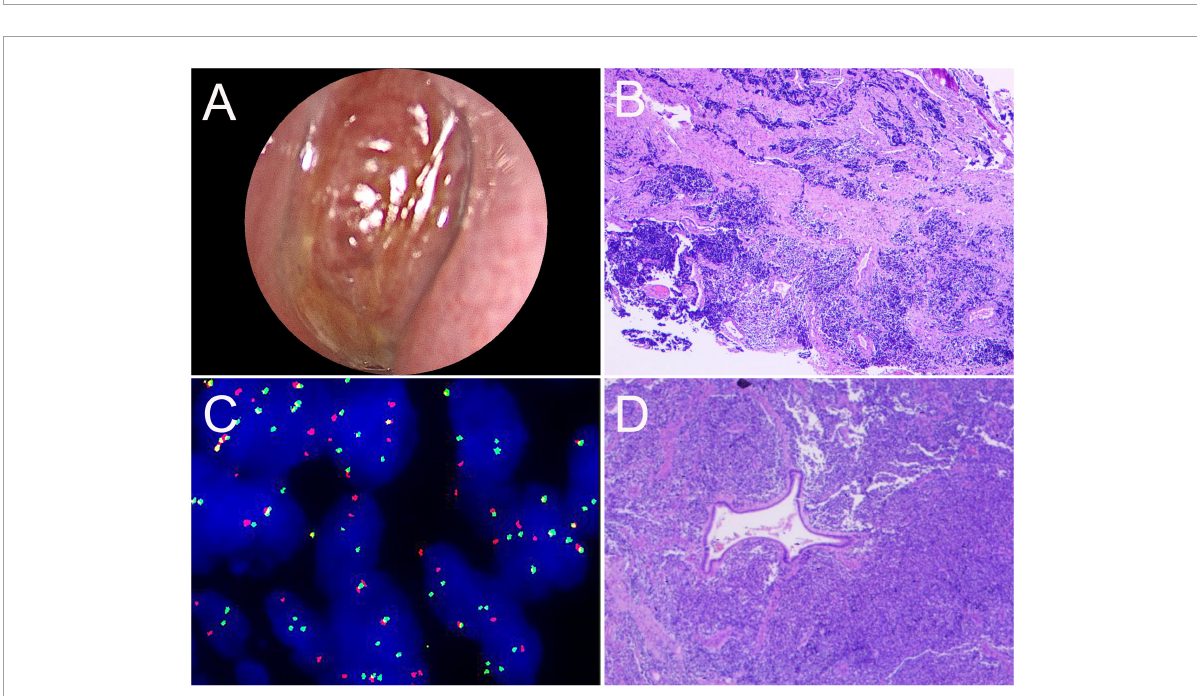
FIGURE7 Nasal endoscopic images of the nasal sinuses and histopathological results of ARMS in case 2. (A) Nasal endoscopy of the patient revealed a reddish neoplasm in the left middle nasal tract. (B) HE staining of biopsy tissue ( × 40). (C) The gene test image showed positive FKHR gene rupture ( × 1,000). (D) Postoperative pathological HE staining ( ×